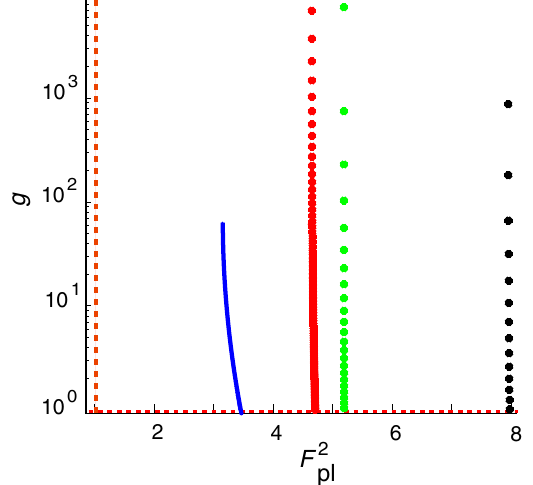
for four different microcavities: pl ¼ 1 . Note pl 1 . 4 and k 0 . 1 for p ¼ s ¼ 1 . 6 and k 0 . 06 for the p ¼ s ¼